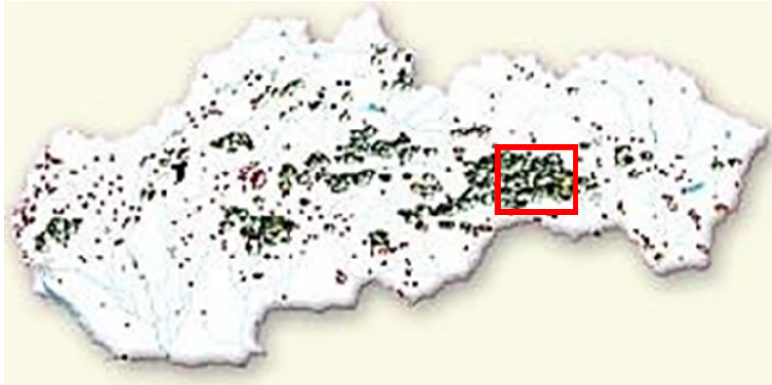
Figure 1. Old mining works in the territory of Slovakia, with the marked location of sampling region